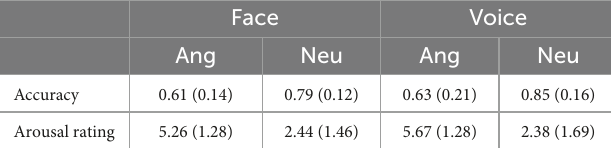
TABLE 2 Mean and standard deviations (in parentheses) for the categorization accuracy and rating arousal of faces and voices in each